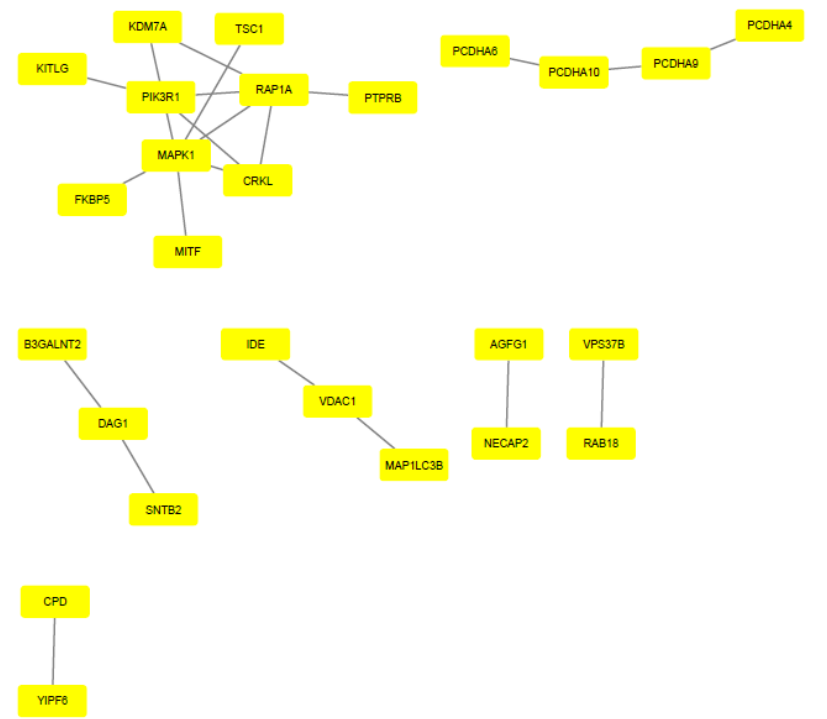
Figure 2. Protein–protein interaction of upregulated miRNA target genes. Gene interaction was performed using STRING and Cytoscape tools. Genes are represented by yellow rectangles and lines represent protein–protein associations. Table 2. Enriched terms generated by Gene Ontology for the main target genes of downregulated miRNAs. Pathway